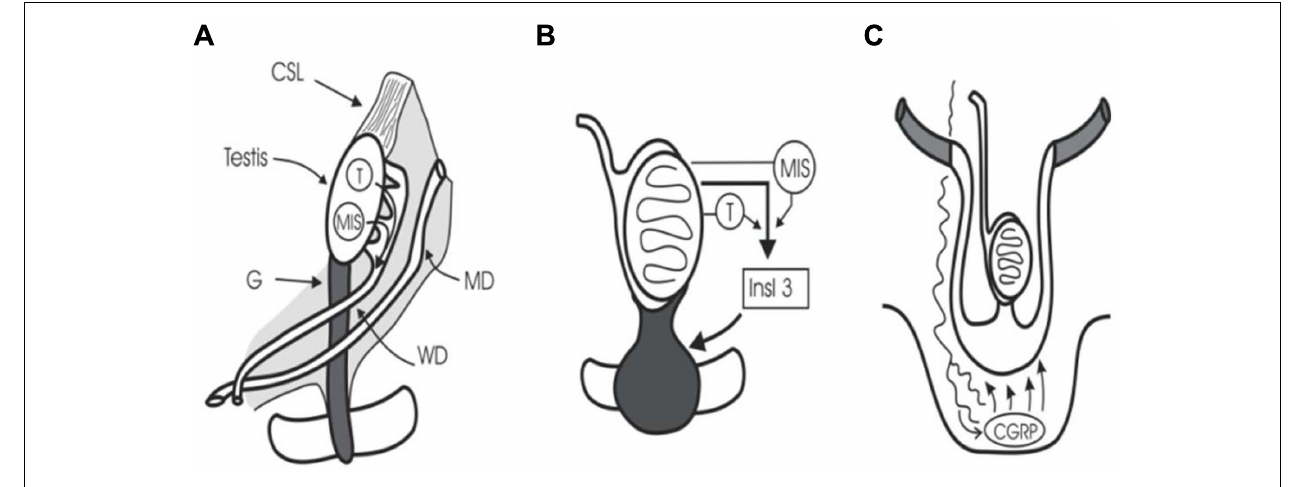
FIGURE 1 |Testicular descent. (A) Cranial suspensory ligament (CSL) and gubernaculum (G) hold the testis.Testosterone (T) and MIS/AMH act onWolffian duct (WD) and Müllerian duct (MD). (B) Insulin 3 (Insl3) causes the gubernacular swelling reaction that holds the testis near the groin